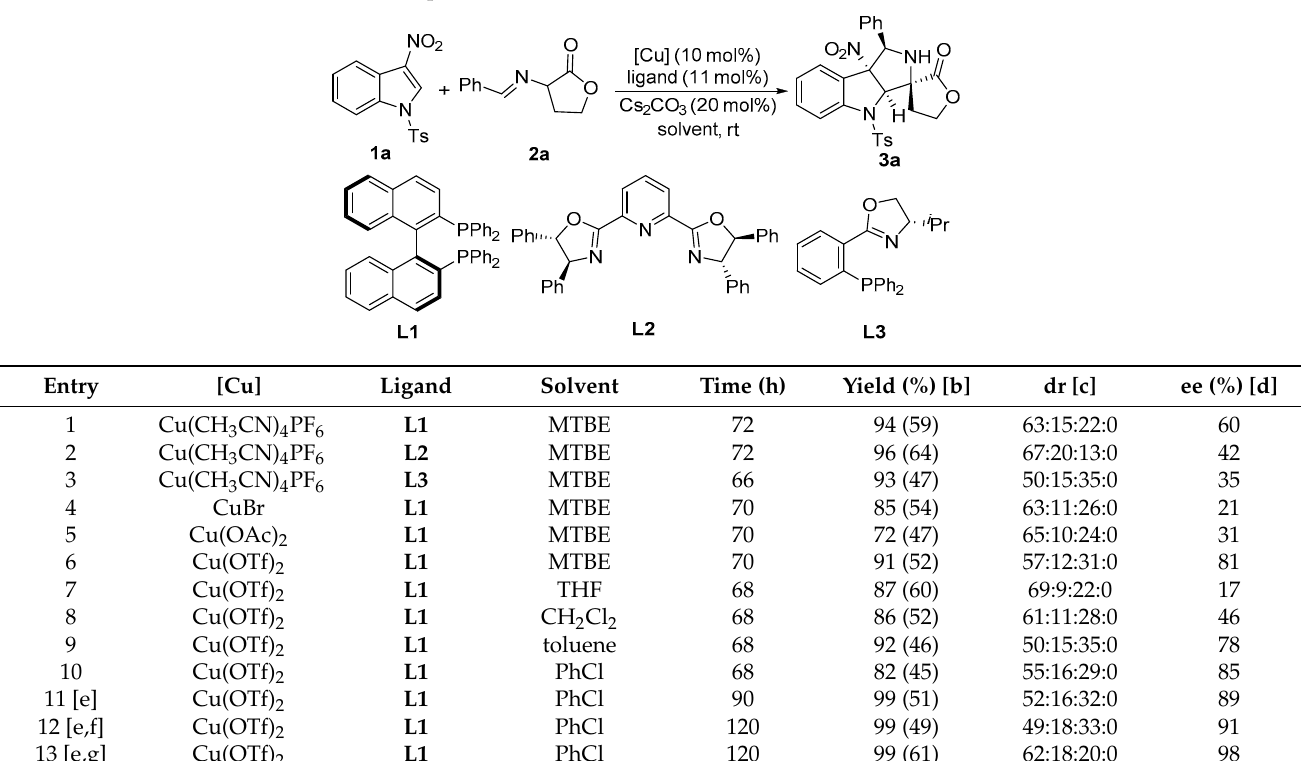
Table 1. Optimization of reaction conditions [a].